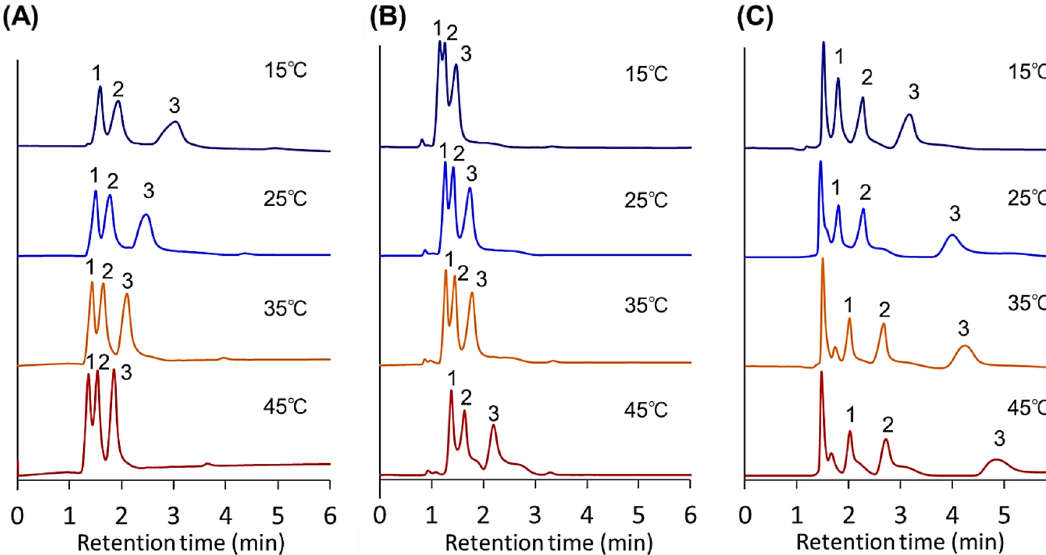
Figure 6. Chromatograms of barbiturates using P(NIPAAm- co -BMA) hydrogel-modified bead columns with ( A ) 7-nm pore-diameter beads, ( B ) 12-nm pore-diameter beads, and ( C ) 30-nm pore-diameter beads as base materials. Mobile phase was pure water. Elution of analytes was monitored at 220 nm at a mobile-phase flow rate of 1.0 min/L. Peak 1 = barbital; 2 = allobarbital; and 3 = phenobarbital.